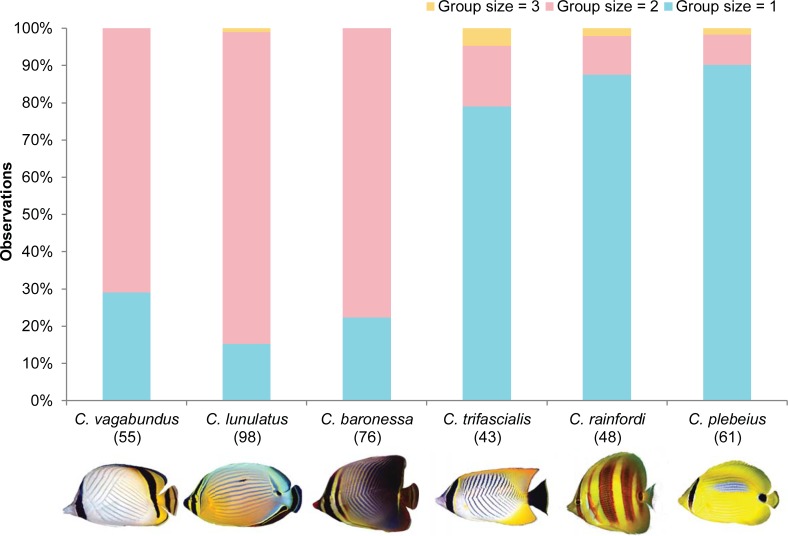
Group size frequency distribution of six Chaetodon spp. at Lizard Island.Numbers in parentheses indicate sample size of total observations of groups.